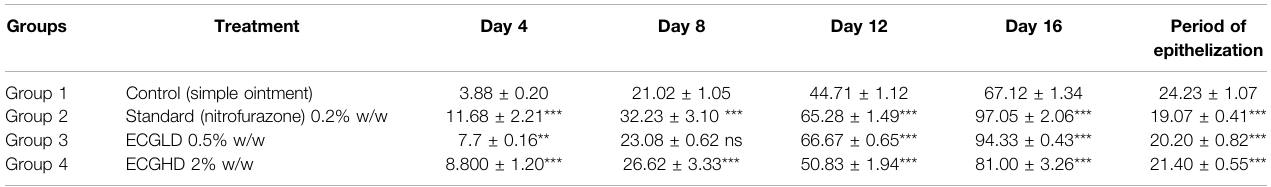
TABLE4| Effectoftopicalapplicationofanointmentcontainingethanolicextractof C.gigantea leavesonwoundcontractionofexcisionwound.Meanpercentageofwound contraction ± SEM. Groups Treatment